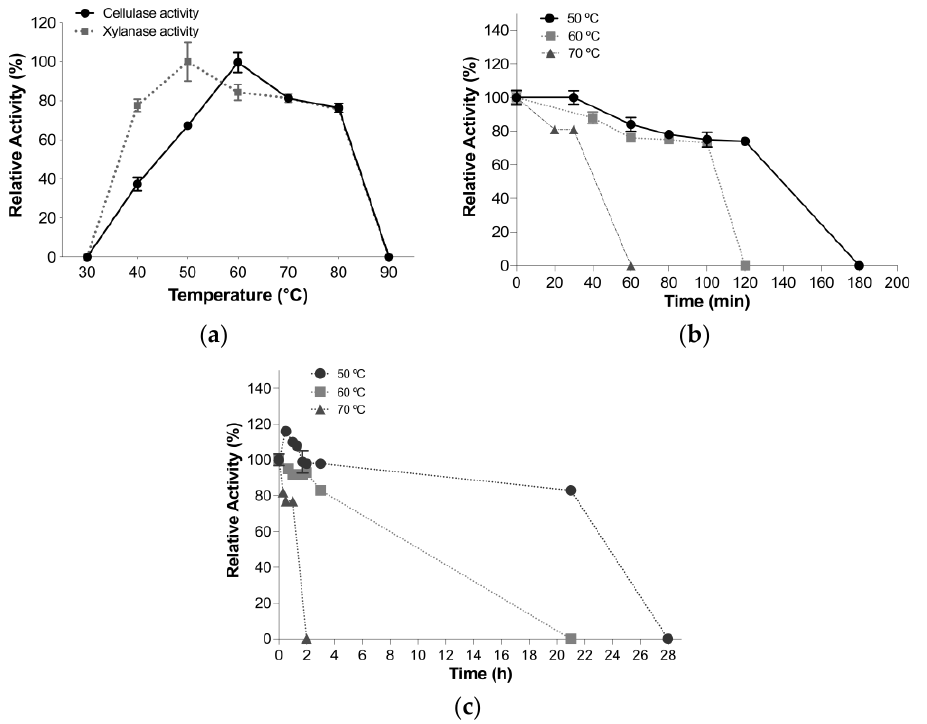
Figure 5. ( a ) Temperature profile of cellulase and xylanase activity of TtCel7A, incubated with 0.6% ( w / v ) of the substrate in 50 mM acetate buffer, pH 5.5. ( b ) Thermal stability of cellulase activity of TtCel7A incubated at 50 (circle), 60 (square), and 70 ◦ C (triangle) without substrate. ( c ) Thermal stability of xylanase activity of TtCel7A incubated at 50 (circle), 60 (square), and 70 ◦ C (triangle) without substrate. Table 2. Kinetic properties of TtCel7A from T. terrestris